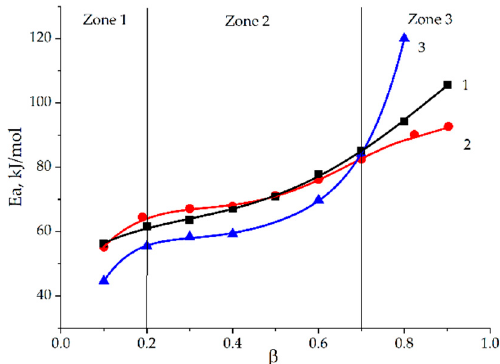
Figure 8. The Ea-dependencies (Ea) on the degree of conversion ( β ) according to the Friedman method for formulations 1–3.